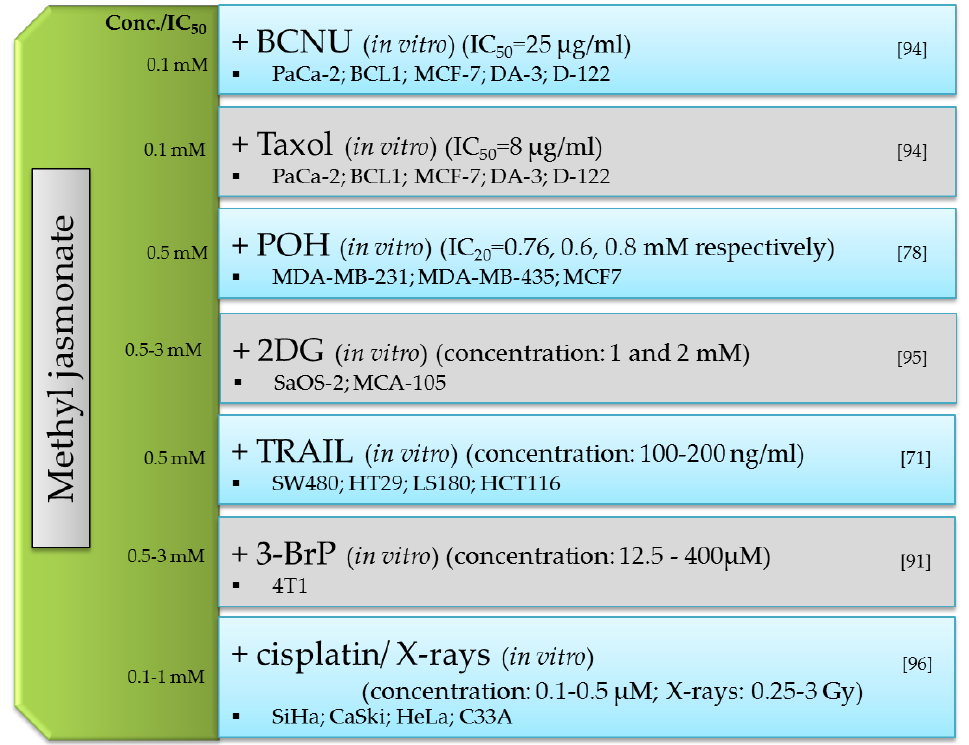
Figure 7. Therapeutic effects of combining MJ with anticancer compounds.